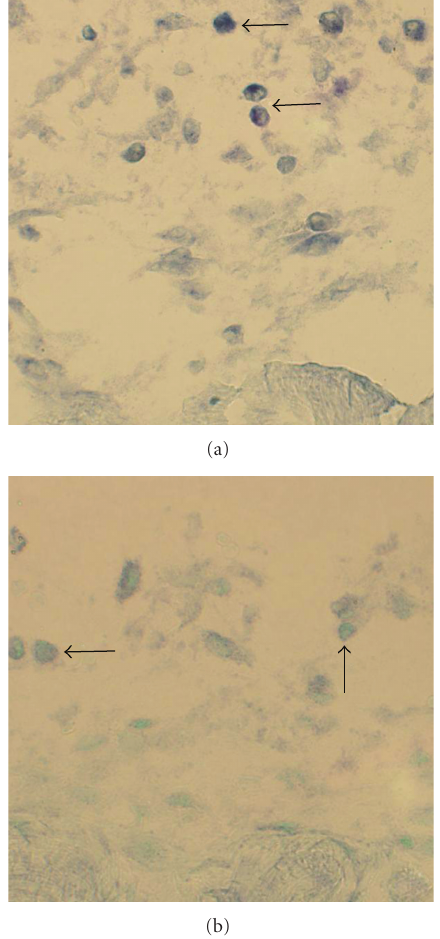
Figure 7: In situ hybridization for the demonstration of TNF- alpha mRNA in inflammatory cells. Adjacent sections are shown: antisense staining (a), and sense staining (b). There are reactions in (a) but not in (b). The arrows point at inflammatory cells.